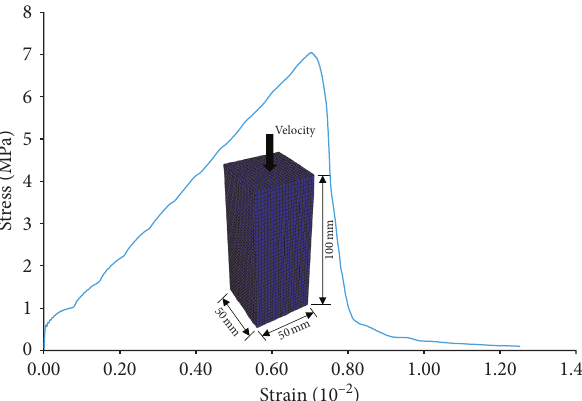
Figure 4: A sketch of FLAC 3D mesh and the stress-strain curve of the numerical model.